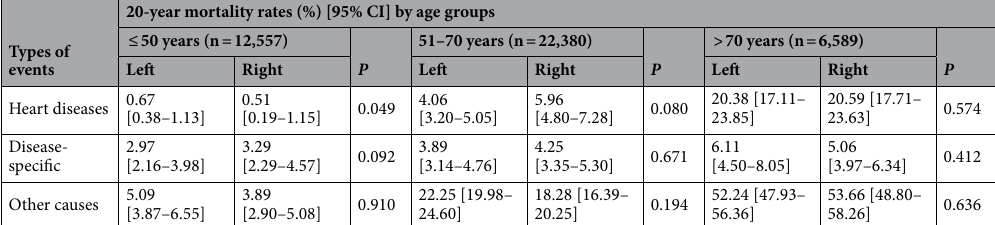
Table 2. Competing risk analysis of causes of death according to age at diagnosis. CI: confidence